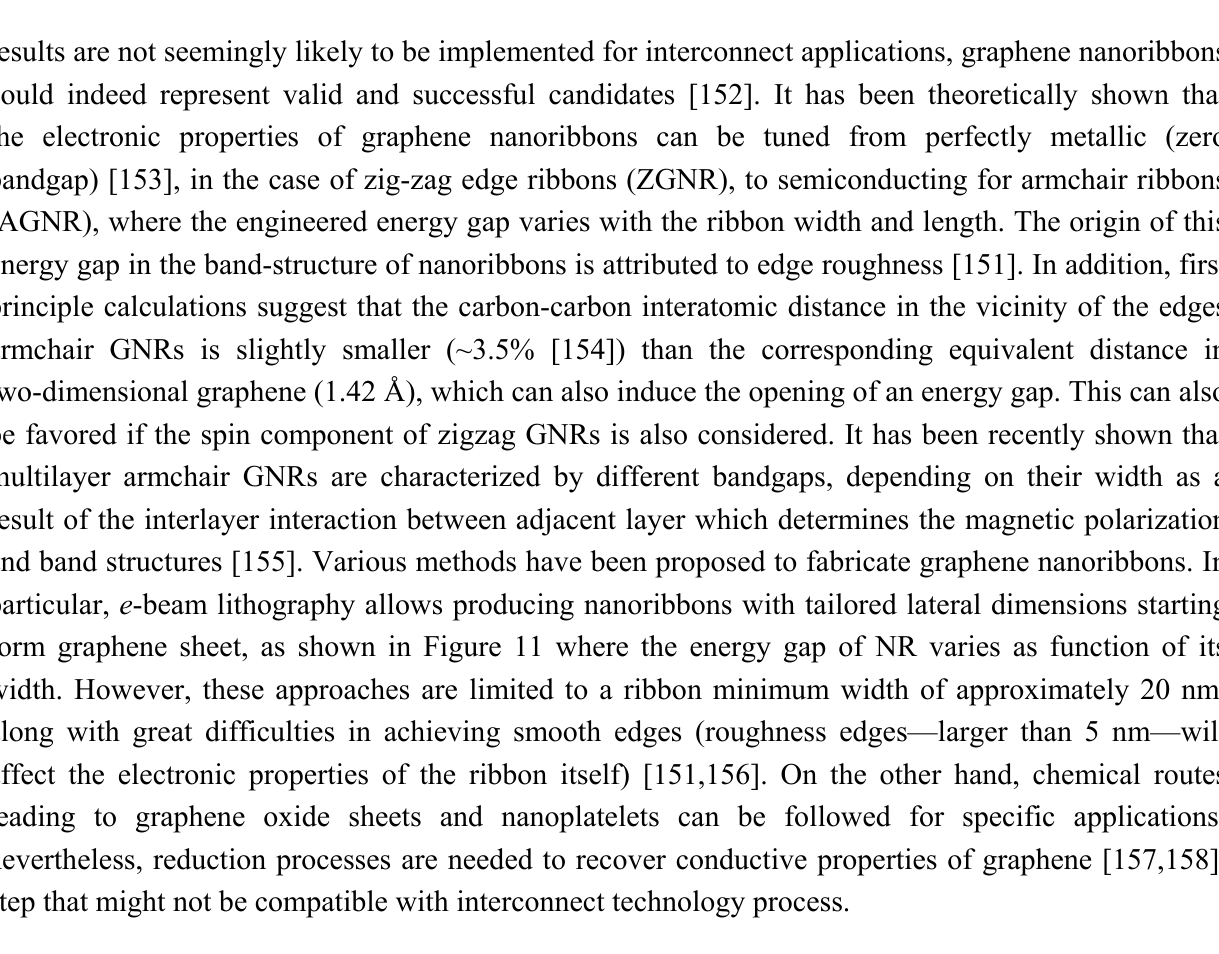
Figure 11. Energy gap dependence from ribbon width in lithographically fabricated graphene nanoribbons. Dashed lines in the inset show the value of as predicted by the empirical scaling of versus W. (Inset) SEM image of a representative graphene nanoribbon-based device